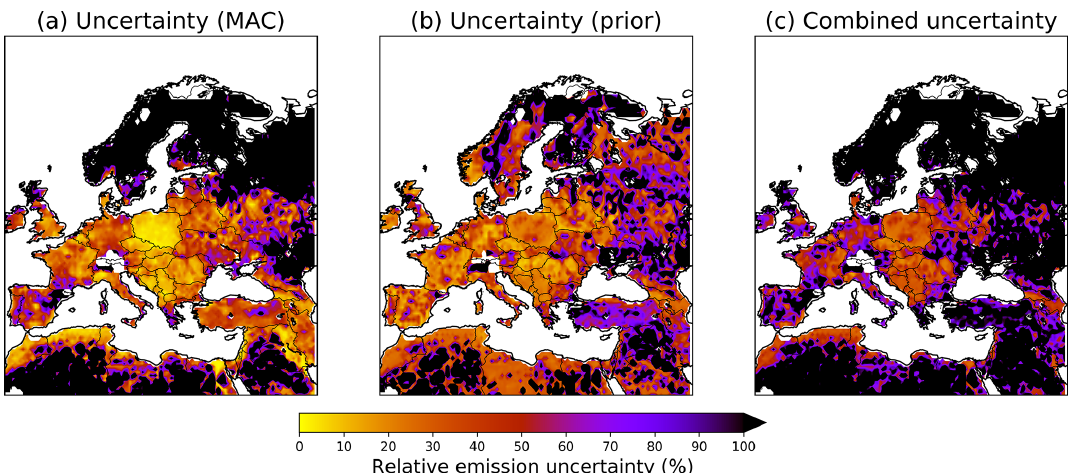
Figure 6. (a) Uncertainty of BC emissions due to the use of variable MAC values to convert from aerosol absorption to eBC concentrations that are used by the inversion algorithm. (b) Uncertainty due to the use of five different prior emissions inventories for BC. (c) Combined uncertainty.